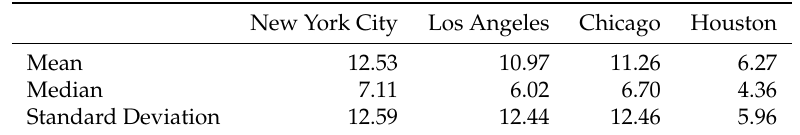
Table 4: Descriptive statistics for the place type Earth Mover’s Distances between January 2020 and January 2021, split by city.